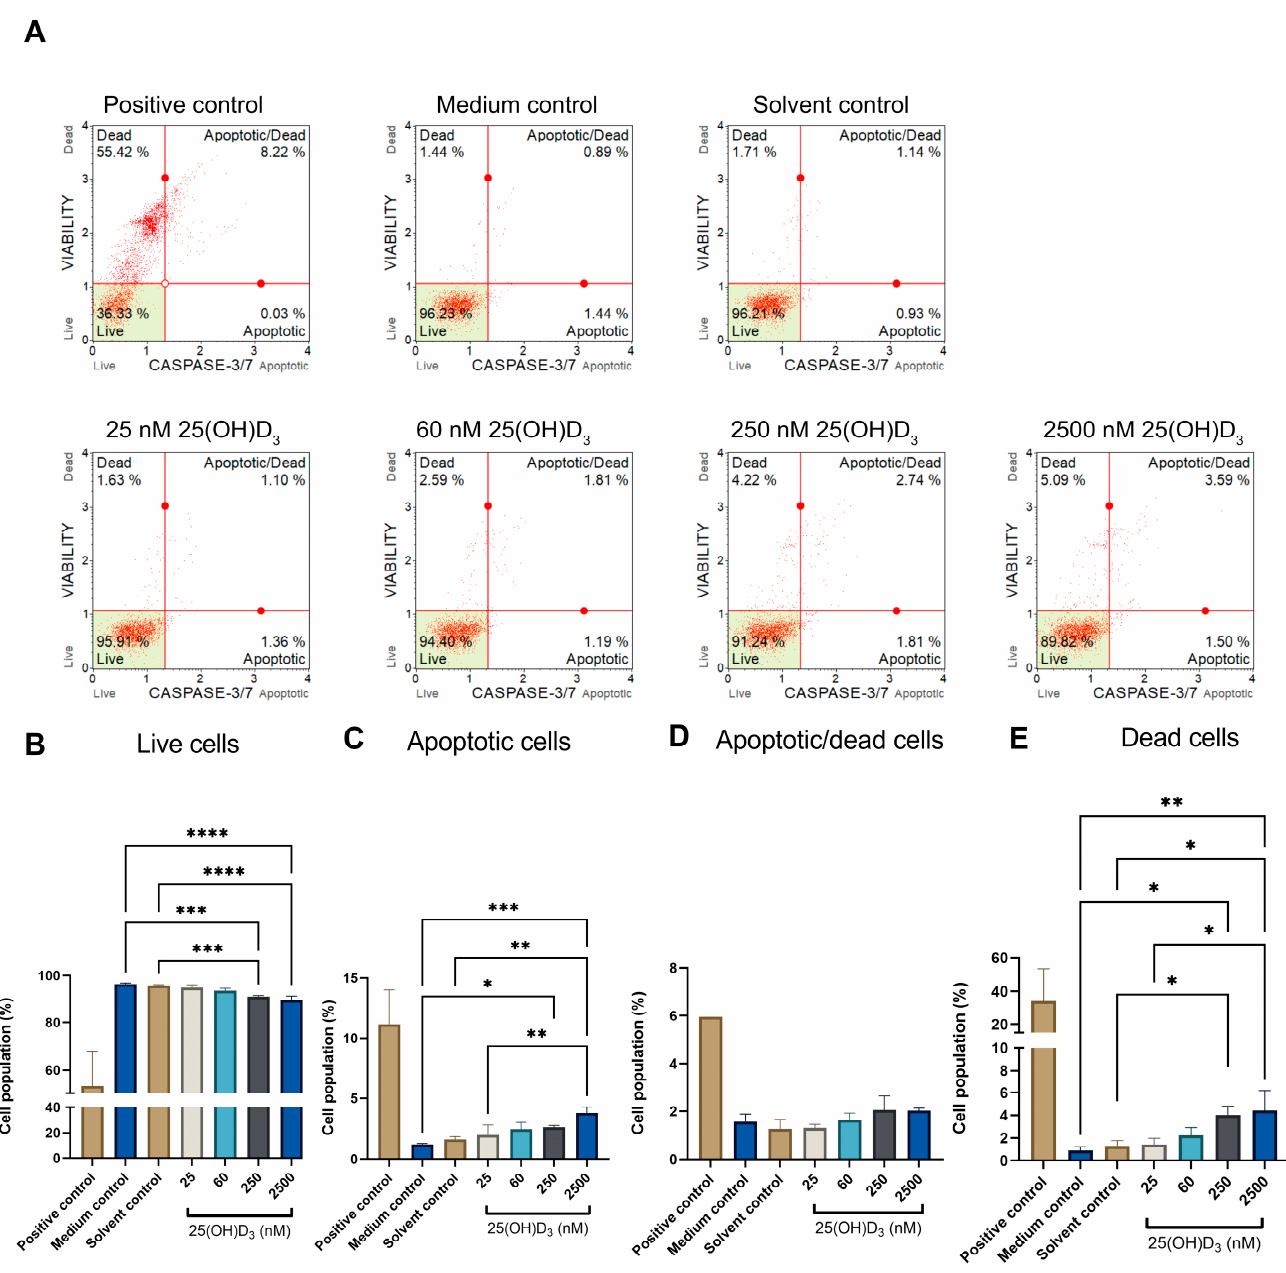
Figure 5. Flow cytometric analysis of effector caspases -3 and -7 in 25(OH)D3-treated SiHa cultures. Dot plot analysis ( A ) shows control and experimental cultures treated with 25(OH)D3, categorised into live, apoptotic, apoptotic/dead and dead populations based on dual staining by propidium iodide and caspases -3 and -7. The cell population categories were analysed and represented in bar graphs ( B – E) : live ( B ), apoptotic ( C ), apoptotic/dead cells ( D ) and dead cells ( E ). The positive control was treated with actinomycin to a final concentration of 0.1 μ g/mL. Data are expressed as mean (±SEM) from three independent experiments, each performed in triplicate (* p ≤ 0.05; ** p ≤ 0.01; *** p ≤ 0.001, **** p ≤ 0.0001).